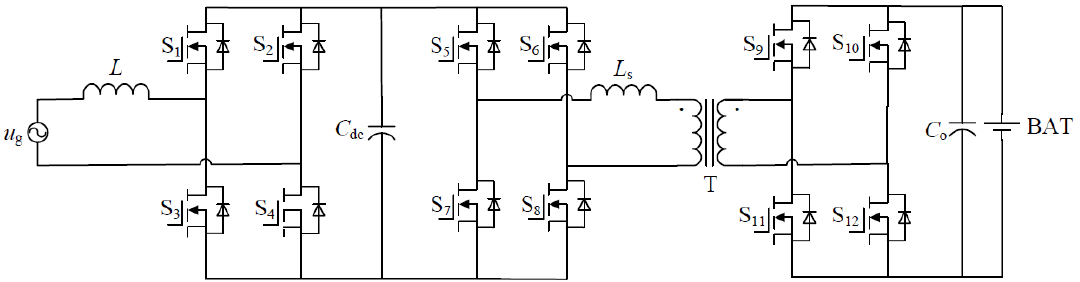
Figure 15. The two-stage topology with PWM convertor and active double bridge converter.